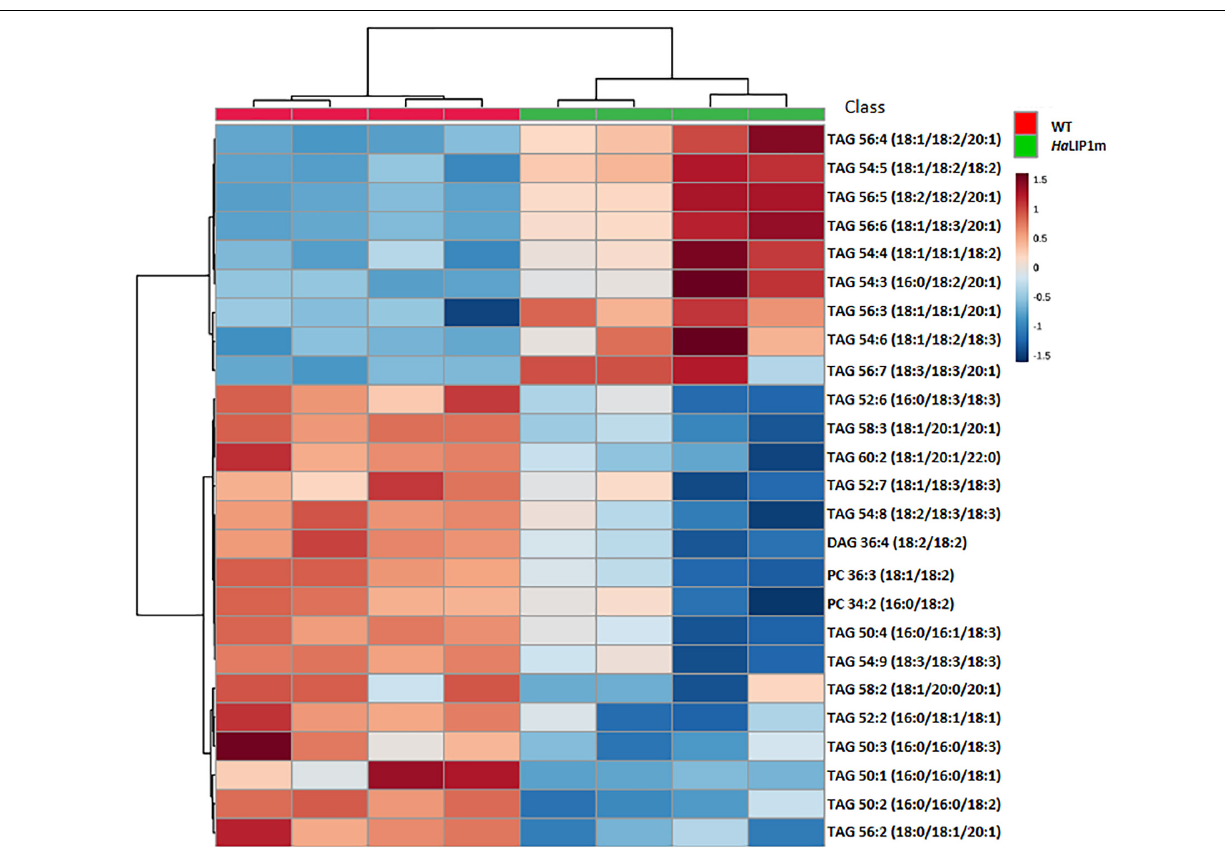
Frontiers in Plant Science |